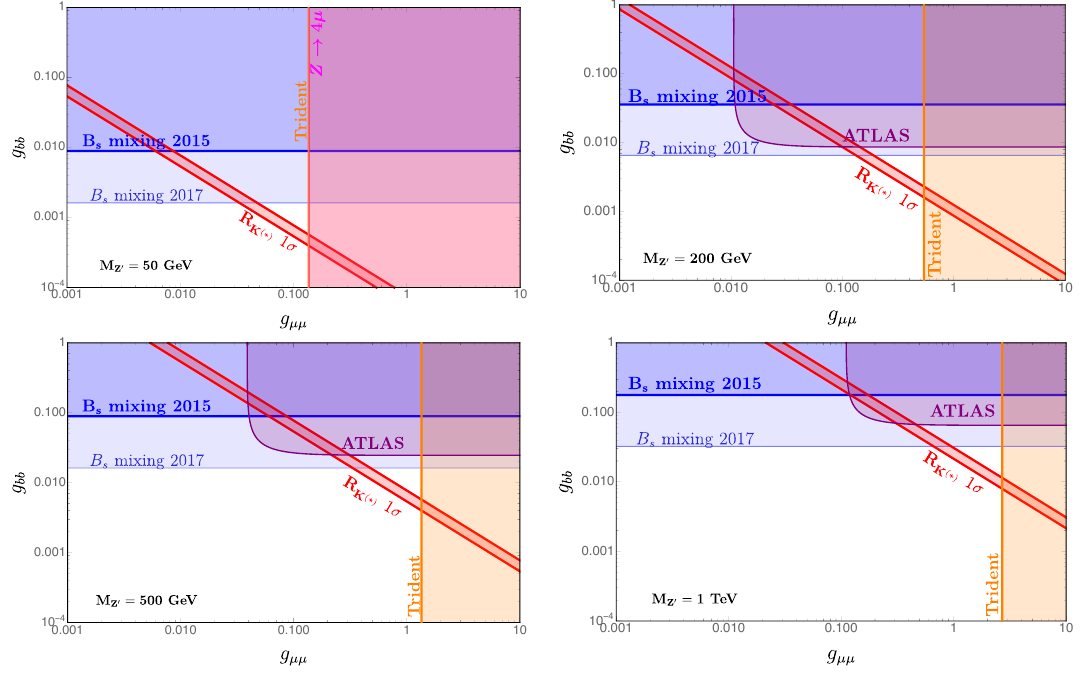
Figure 3 . Bounds on the parameter space in the ( g (cid:22)(cid:22) ; g bb ) plane for (cid:12)xed Z 0 masses: 50, 200, 500 and 1000 GeV, as indicated on each panel. The red bands explain R at 1 (cid:27) . The blue and orange K ( (cid:3) ) areas show the B s (cid:0) B s mixing [56] and neutrino trident [61] 2 (cid:27) exclusions, respectively. For low Z 0 masses we have additional constraints from Z ! 4 (cid:22) as shown in pink. The ATLAS limits [66] from dimuon resonance searches for 36 fb (cid:0) 1 luminosity are given in purple for larger Z 0